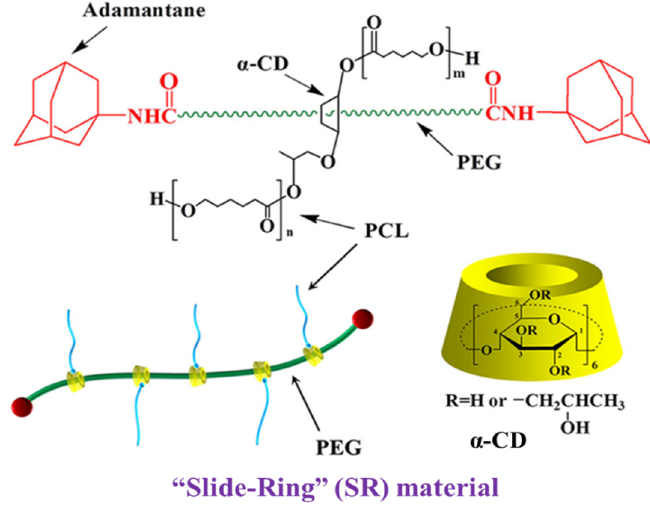
Figure 1. Structure of the slide-ring material. Reprinted from [13] with permission from Elsevier.